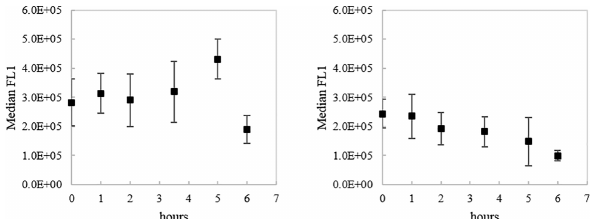
Fig 3. Nucleic acid intensity variation determined by FCM SYBR green staining in PSB C . okenii . MedianFL1 signal intensity variation in function of light for PSB C . okenii under light (left) and dark (right) incubation after SYBR green stainingfor relative detectionof doubleor single strandedDNA or RNA.